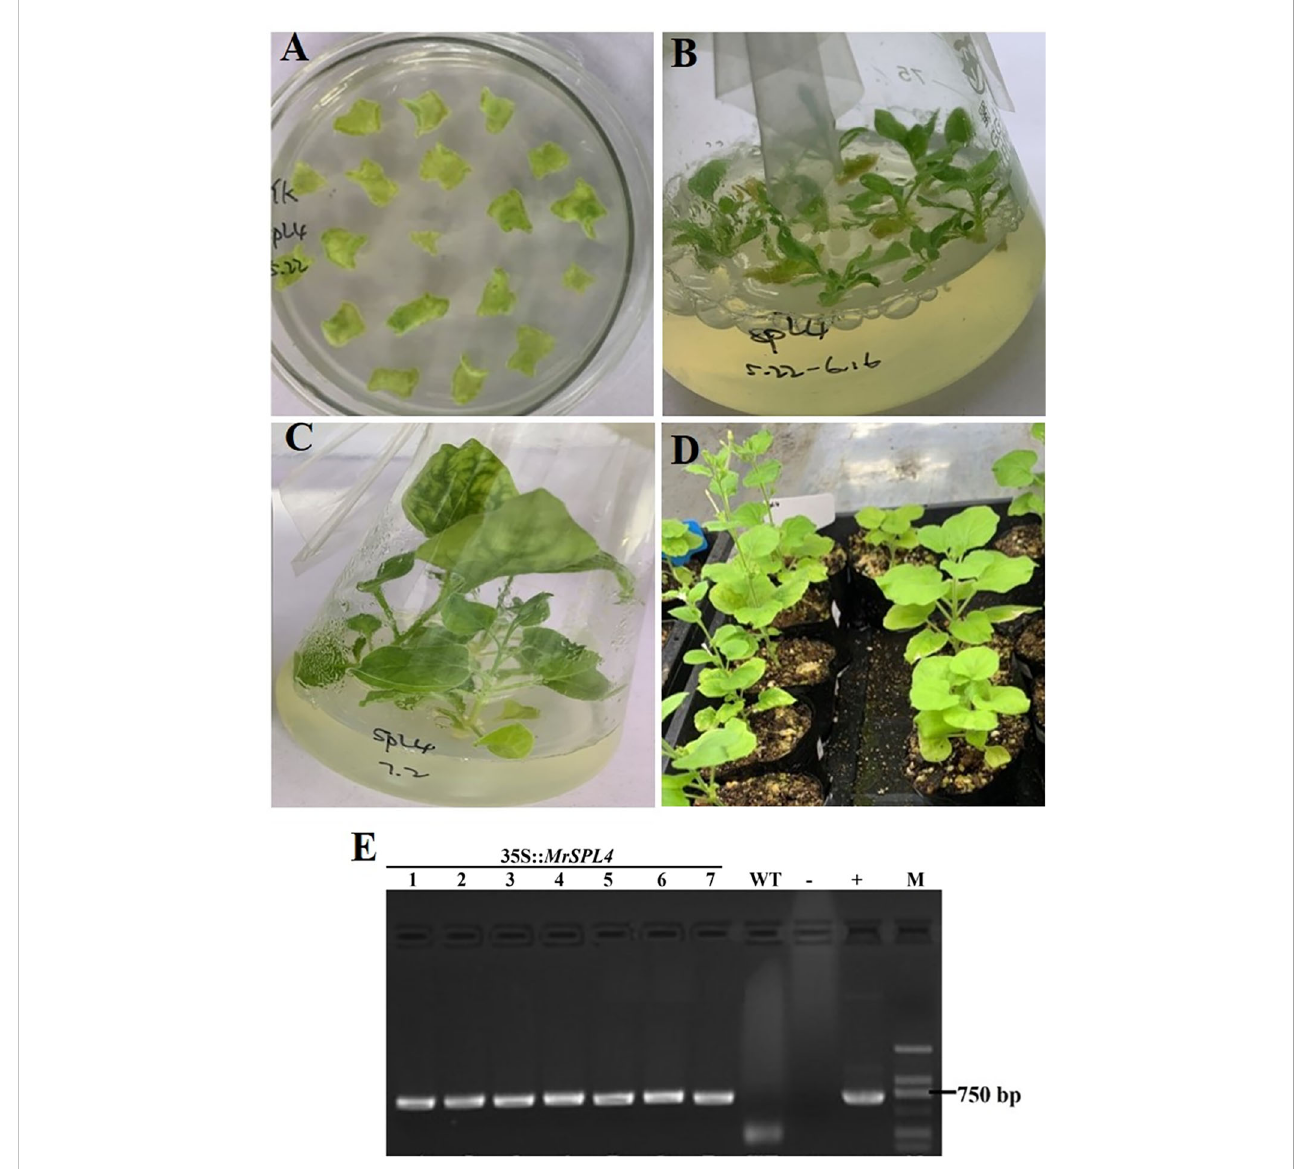
FIGURE 5 Regeneration of positive tobacco plants and PCR identi fi cation of Kan resistance. (A) Kanamycin medium for bud differentiation. (B) Resistant plant culture. (C) Rooting of resistant plants. (D) Transplanted seedling culture. (E) Transgenic tobacco identi fi cation using genomic PCR, 1~7: resistant regenerated tobacco, W: negative control, -: blank control, +: positive control, M: DL2000 DNA